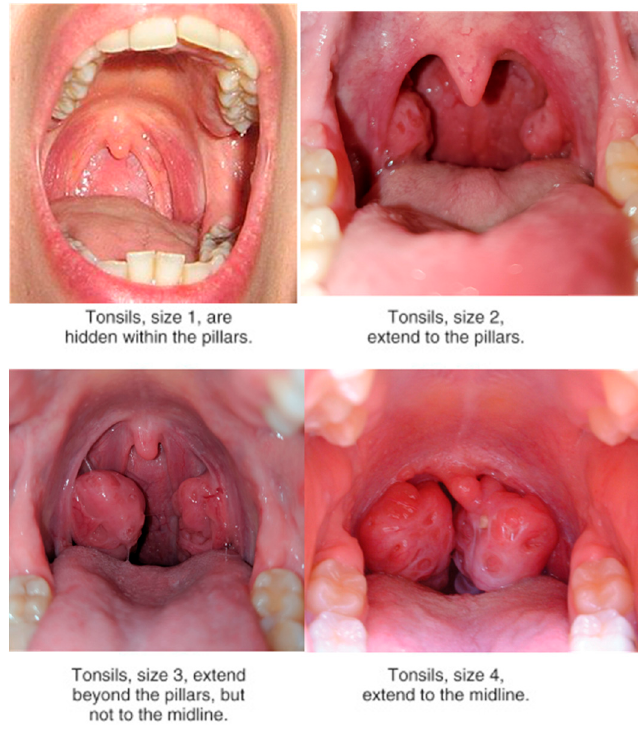
Figure 1. The image shows details of the Mackenzie classification. We used pictures from our sample to detail the differences between different severities of tonsillar